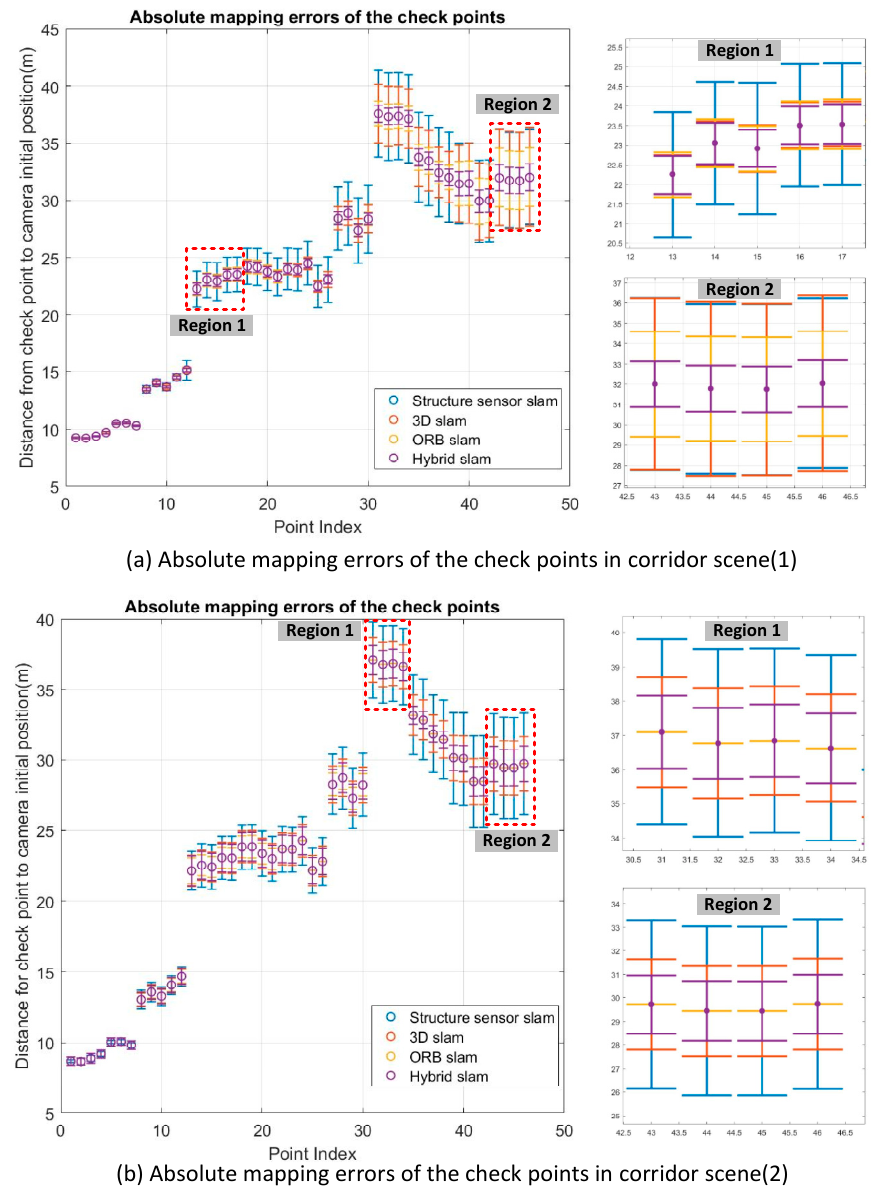
Figure 14. Absolute mapping errors of the checkpoints along with camera trajectories.